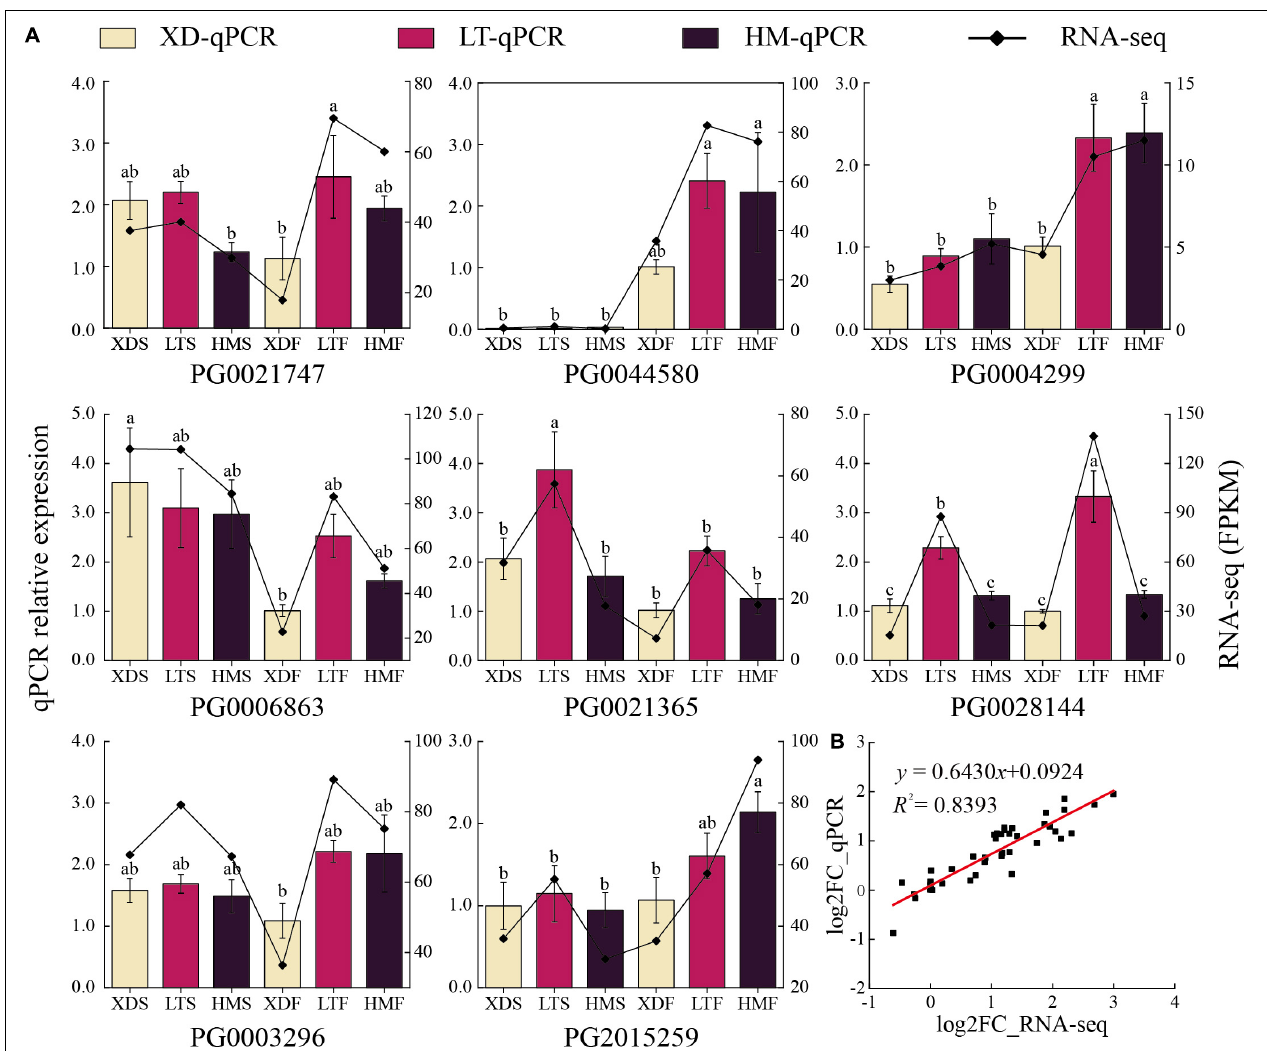
FIGURE 9 | The qPCR expression analyses of eight StNF-Y genes in (A) the skin/flesh (S/F) of white (XD), purple (HM), and red (LT) cultivars. (B) The correlation between qPCR and RNA-seq analysis. Error bars represent the means ± SE of three biological replicates. Different letters above bars denote significant difference at p < 0.05. Column graphs represent the relative expression levels of genes determined by qPCR; the values are shown on the left y -axis, and line graphs represent the FPKMs obtained by RNA-seq; the values are shown on the right y